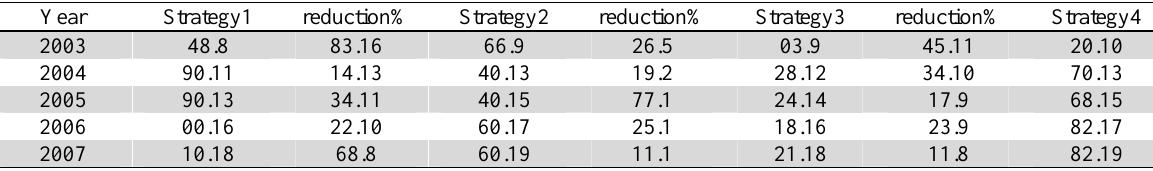
Sum of empty container repositioning base on million TEU under four strategies